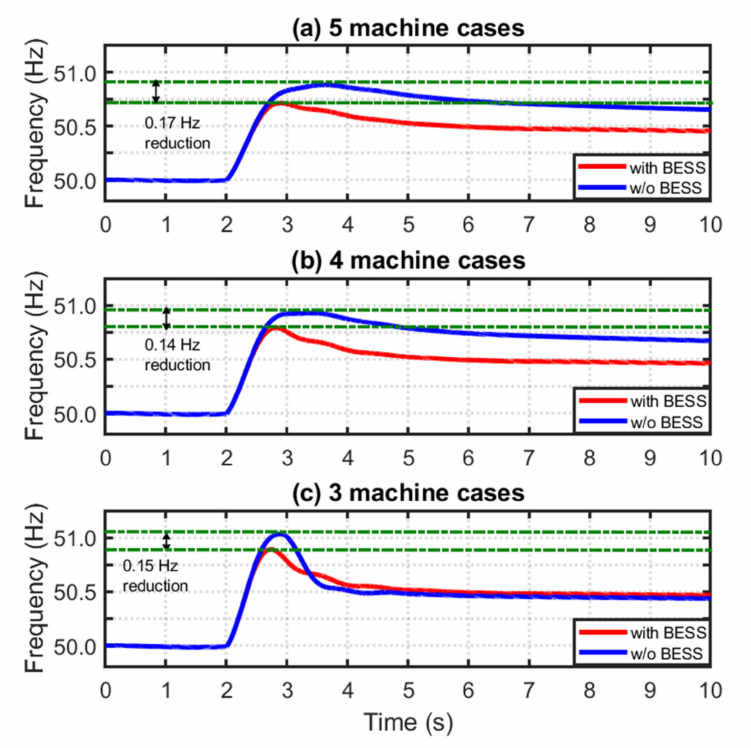
Figure 17. Performance comparison due to 400-MW interconnection trip: ( a ) five-machine case; ( b ) four-machine case; ( c ) three-machine